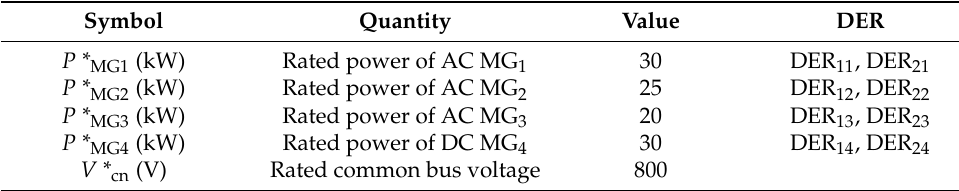
Table 2. Circuit and control